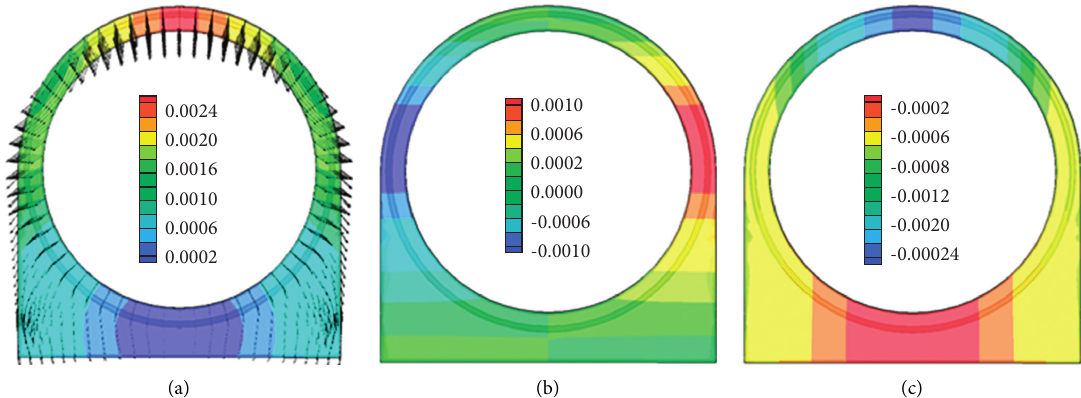
Figure 15: Relative deformation cloud diagram of prestressed culvert structure: (a) resultant displacement; (b) horizontal displacement; (c) vertical displacement.